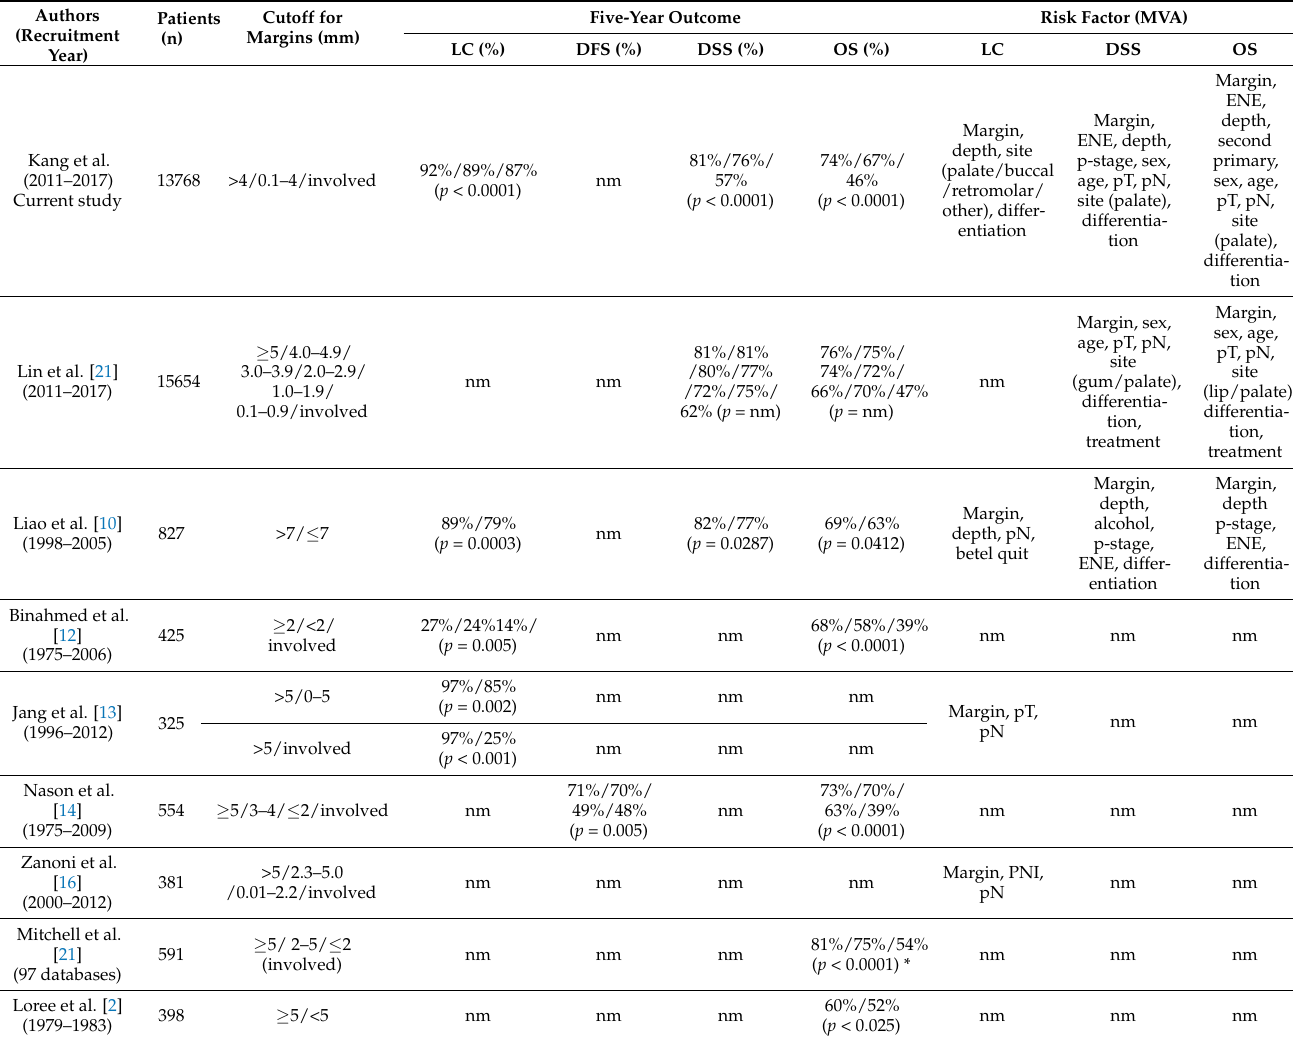
Table 3. Summary of published studies on the prognostic impact of surgical resection margins and associated clinical outcomes in oral